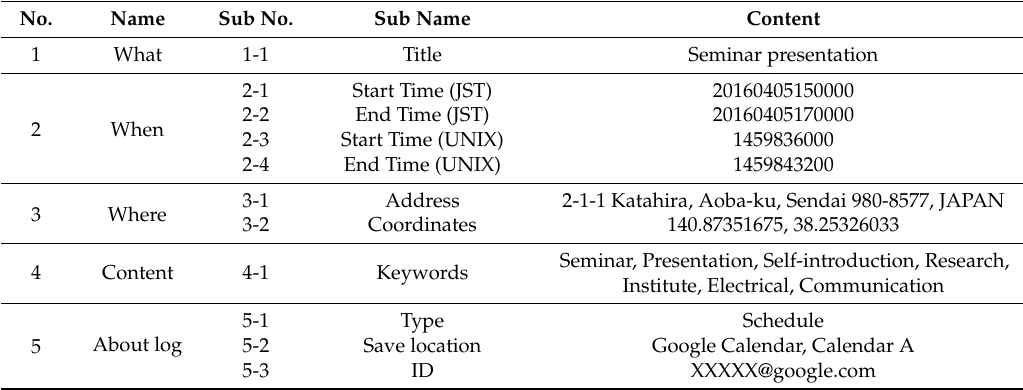
Table 3. Metadata example used in an AIR (seminar